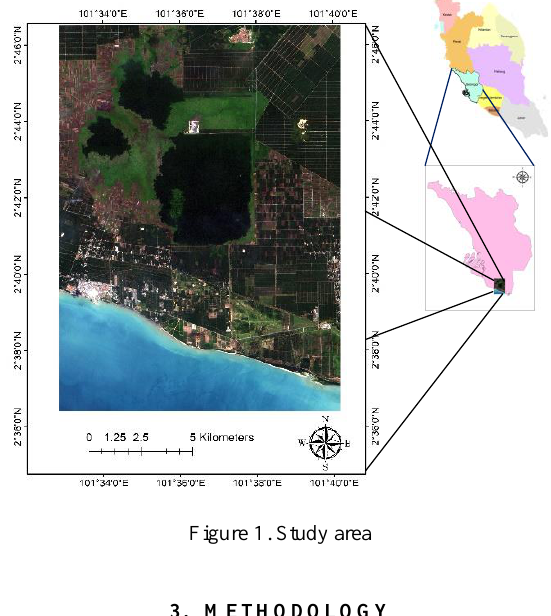
Figure 1. Study area